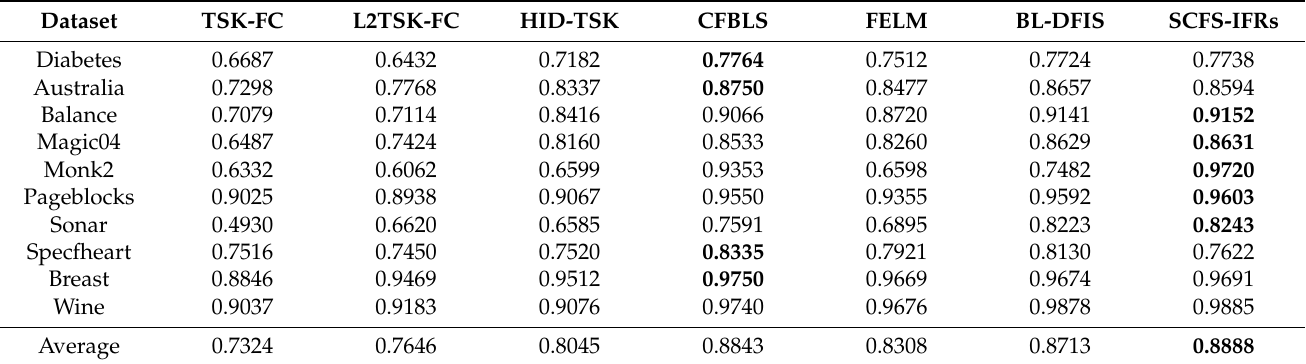
Table 8. Comparisons of classification accuracies on 10 datasets.